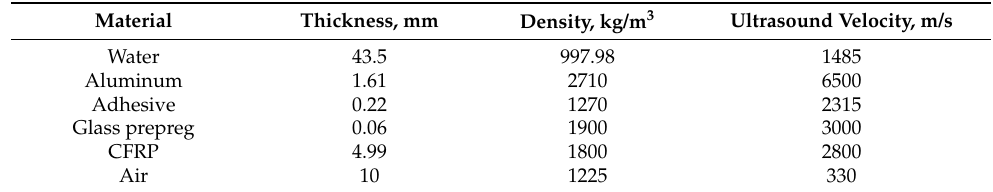
Table 4. Defined material and medium characteristics to model the signal closest to experimental